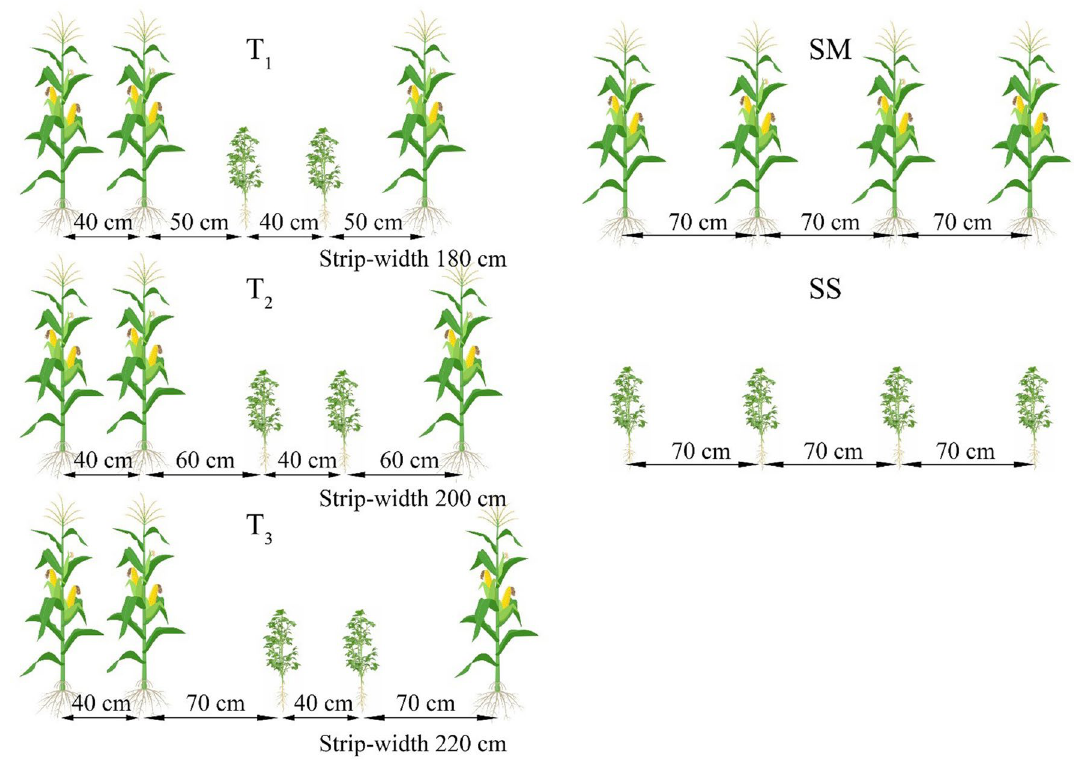
Figure 2. Schematic presentation of the maize soybean relay intercropping system (MSR) as affected by different strip width treatments from 2012 to 2013. In MSR, two rows of soybean were relay-intercropped with two rows of maize after the 60 ± 5 days of maize sowing. Treatment codes represent T 1 (narrow-strips), T 2 (medium-strips), T